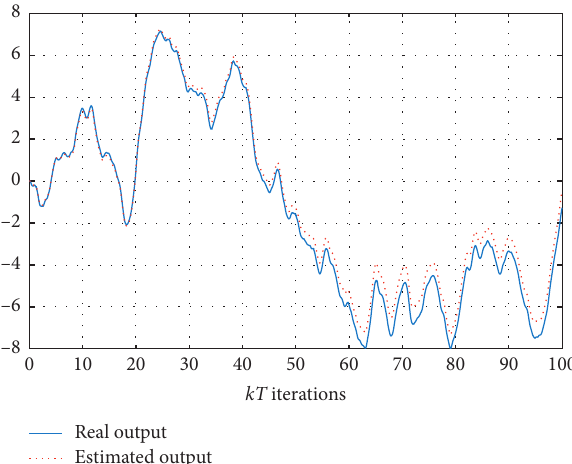
Figure 3: Response of the pitch angle of the open-loop system.